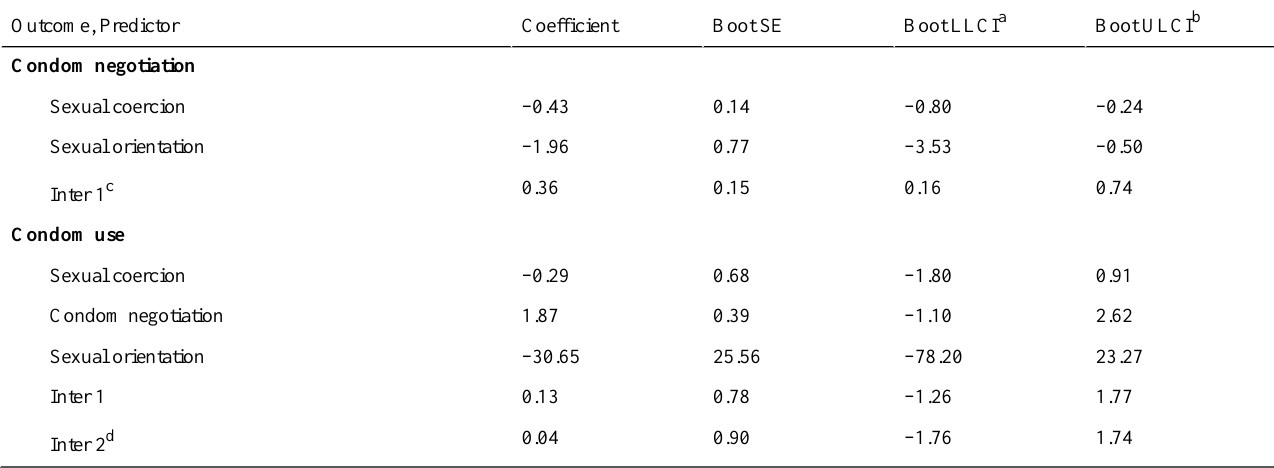
Table 3. The moderating effects of sexual